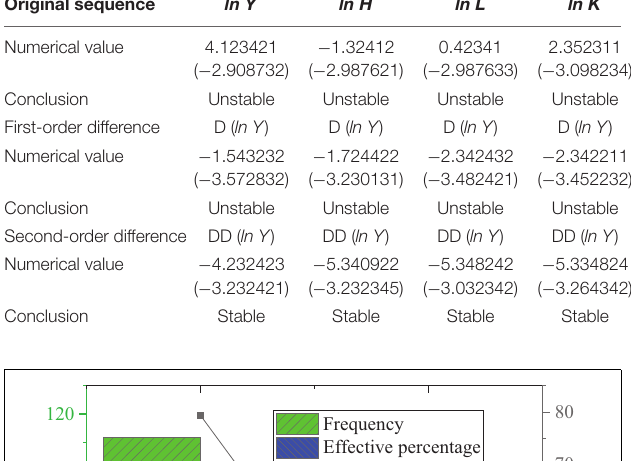
FIGURE 9 | Descriptive statistics of sample entrepreneurs’ educational